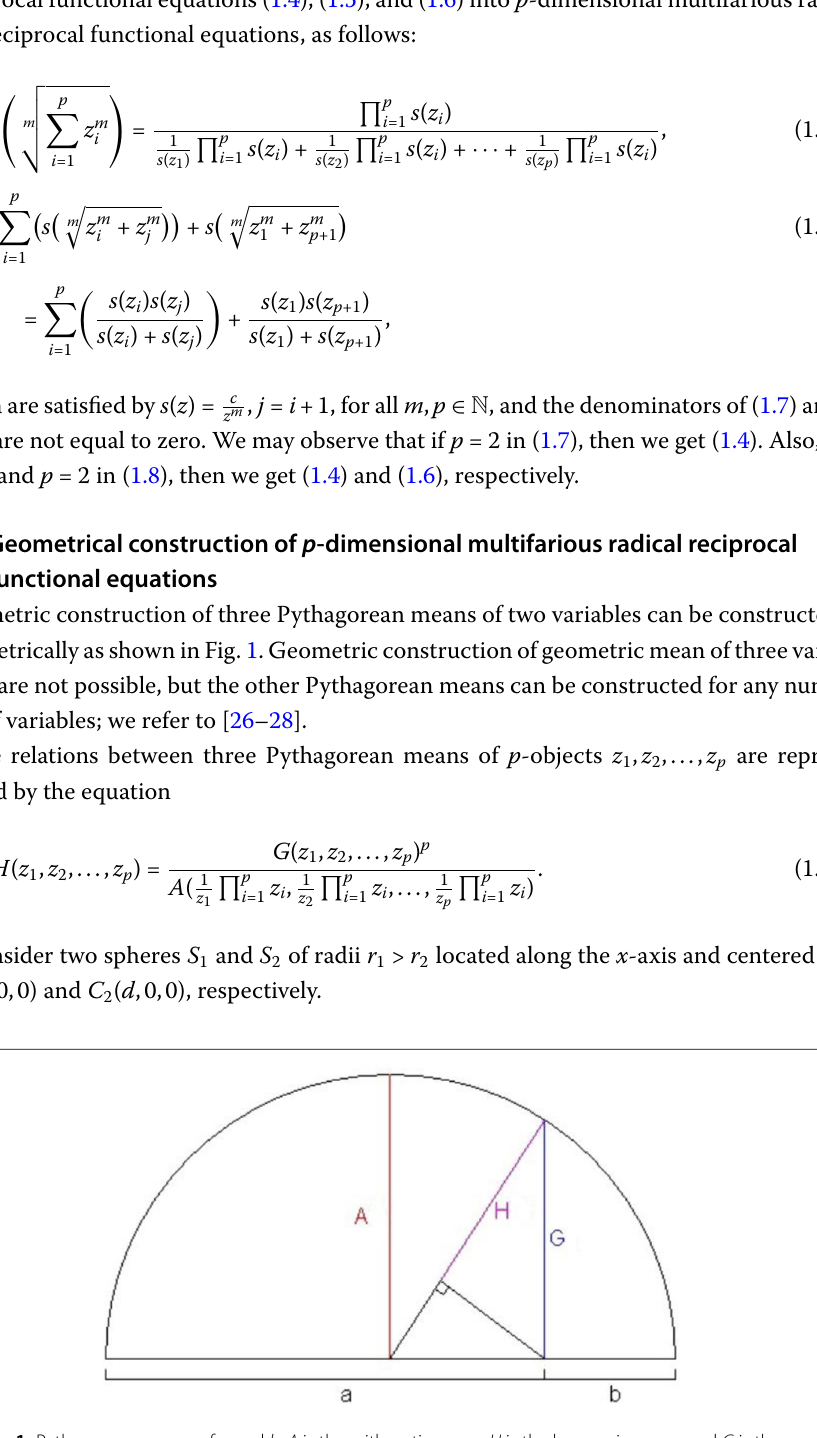
Figure 1 Pythagorean means of a and b : A is the arithmetic mean, H is the harmonic mean, and G is the geometric